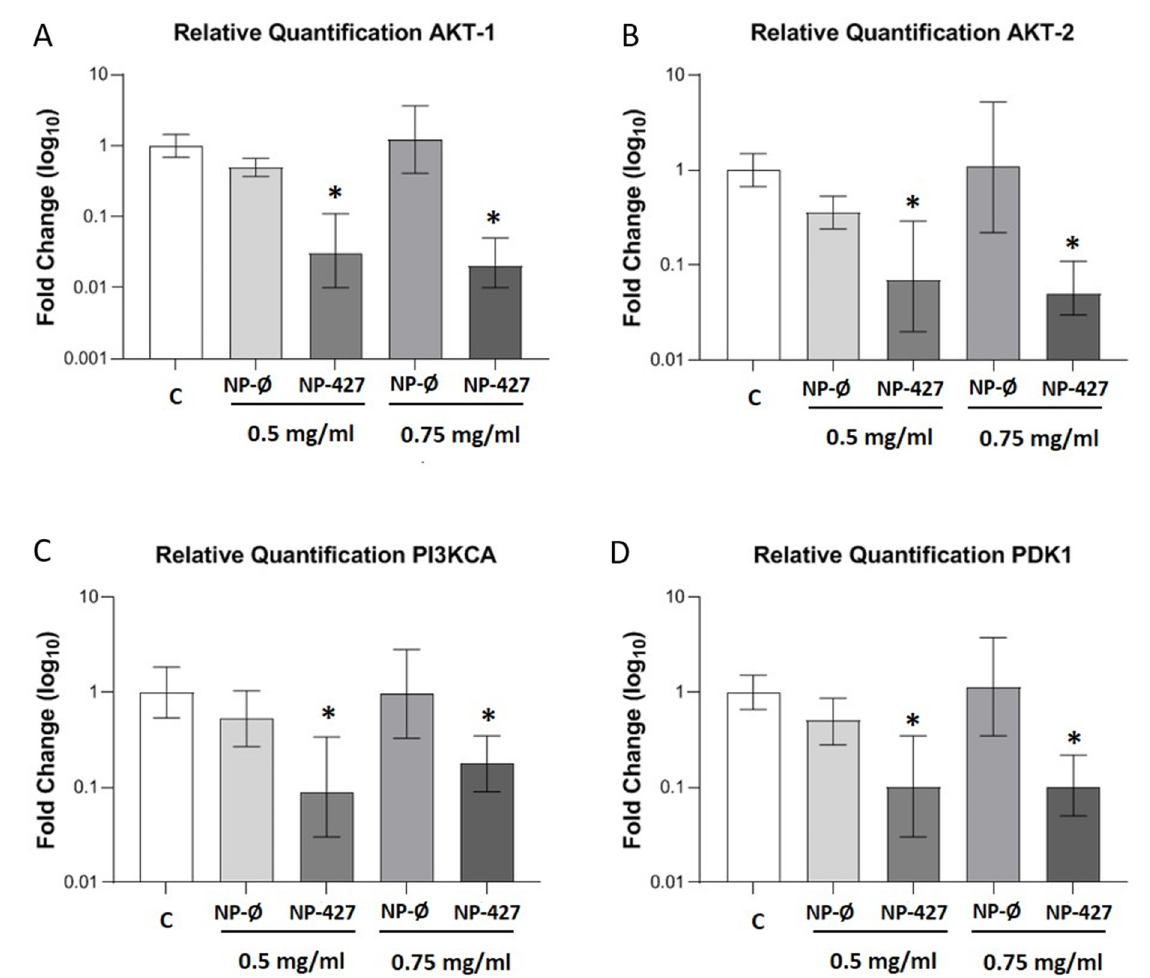
Figure 5. PHT-427-loaded NPs reduced the gene expression of the PI3K pathway in FaDu cells. Gene expression of ( A ) AKT1, ( B ) AKT2, ( C ) PI3KCA, and ( D ) PDK1 in FaDu cultures treated with C (control), NP-Ø (unloaded NPs, 0.5 and 0.75 mg/mL), and NP-PHT427 (PHT427-loaded NPs, 0.5 and 0.75 mg/mL) for 24 h. The diagrams include the mean ± SD Fold change (log 10 ) ( n = 4). * p < 0.05 versus control and NP-Ø groups. Reference genes: GUSB and RPLP0.